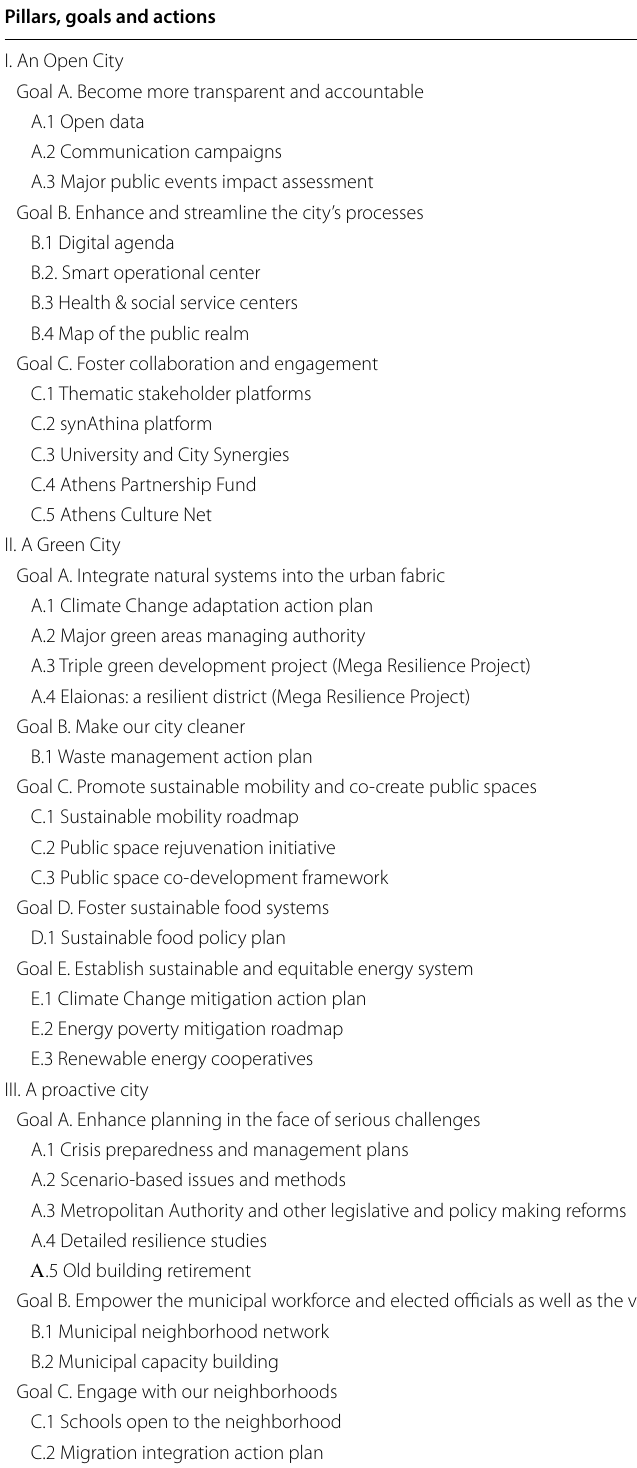
Table 2 The whole set of actions outlined by the Athens Resilience Strategy and the actions addressed to counterbalance climate change Pillars, goals and